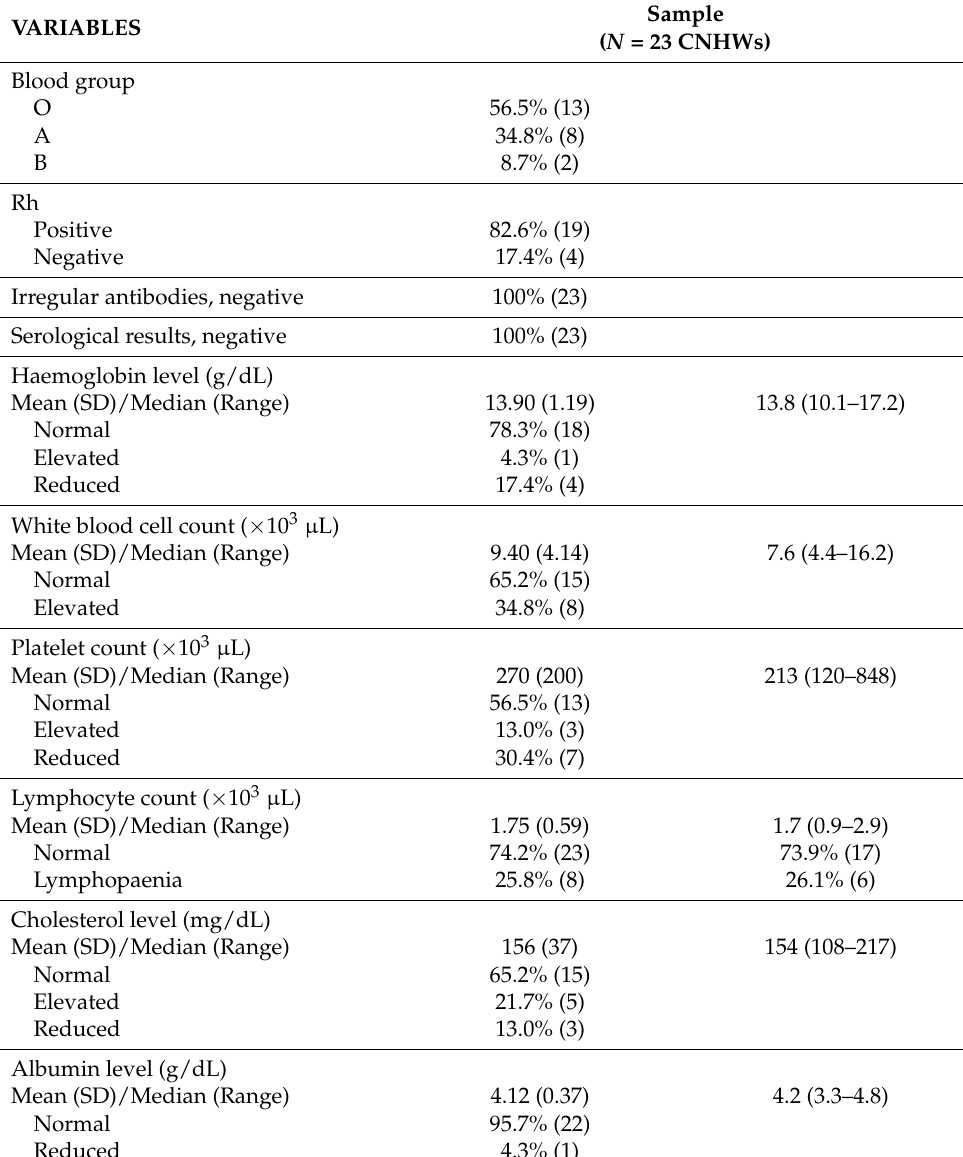
Table 1. Descriptive analysis of the blood test